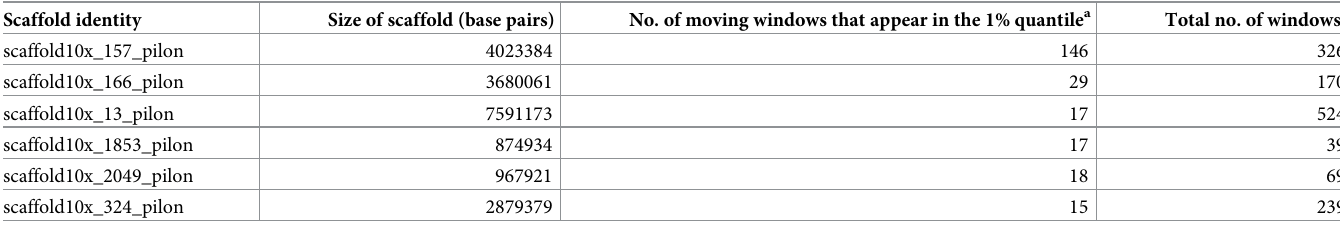
Table 2. Scaffolds showing evidence of selection in the experimental cross. Scaffold identity